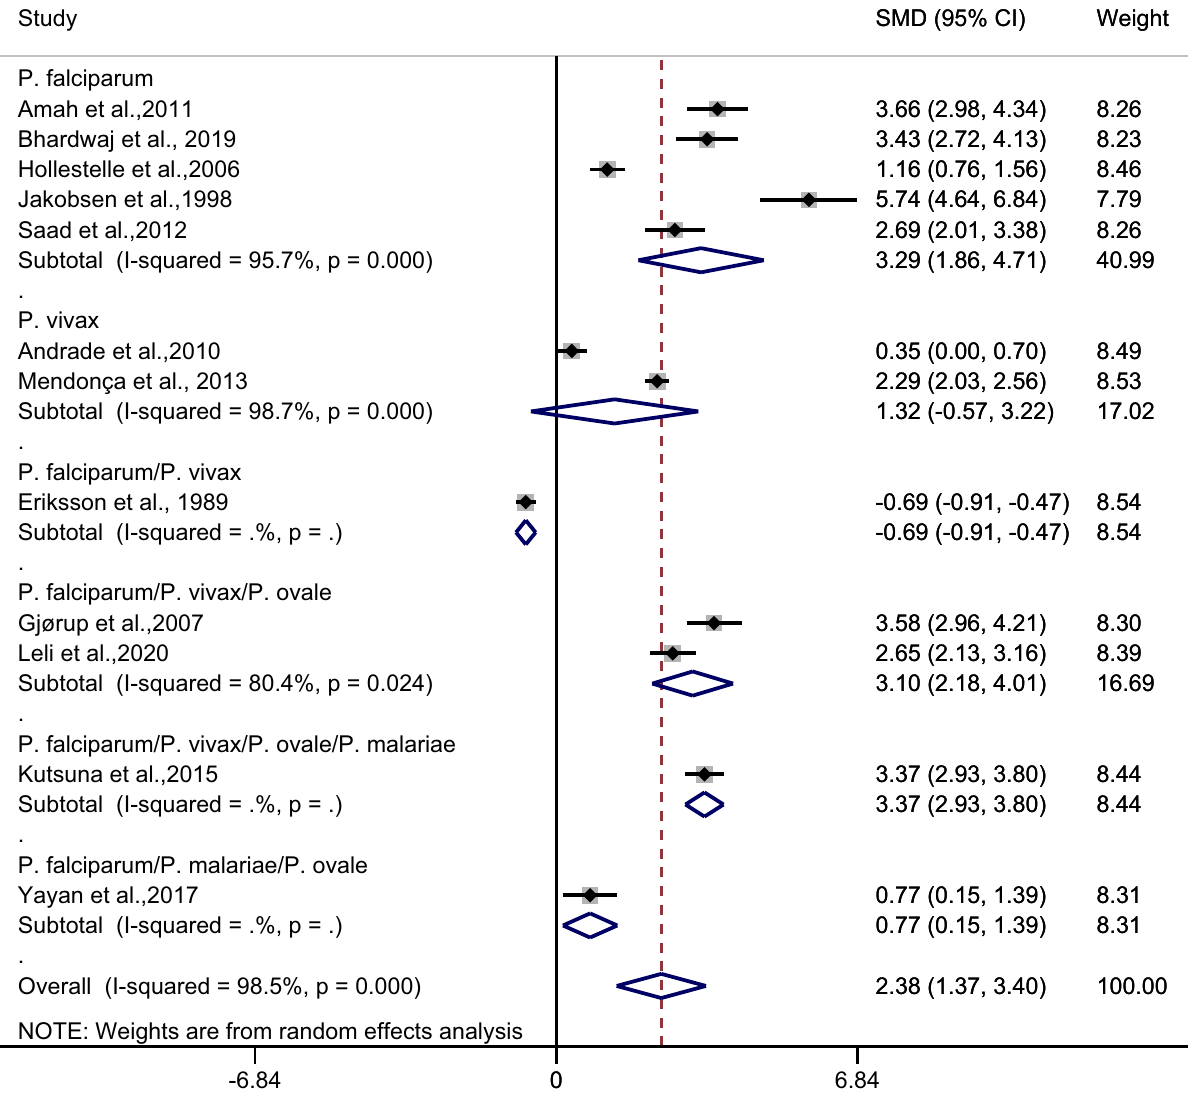
Figure 8. Forest plot demonstrates the difference in the mean CRP level between patients with uncomplicated malaria and healthy/febrile controls by types of infections. SMD, standard mean difference; CI, confidence